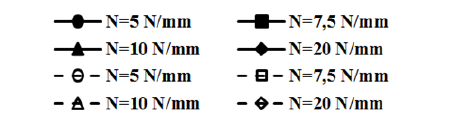
Figure 3. Influence of the radial clearance and load on the maximum contact pressures: D 2 = 40 mm – solid lines, D 2 = 50 mm – dashed lines